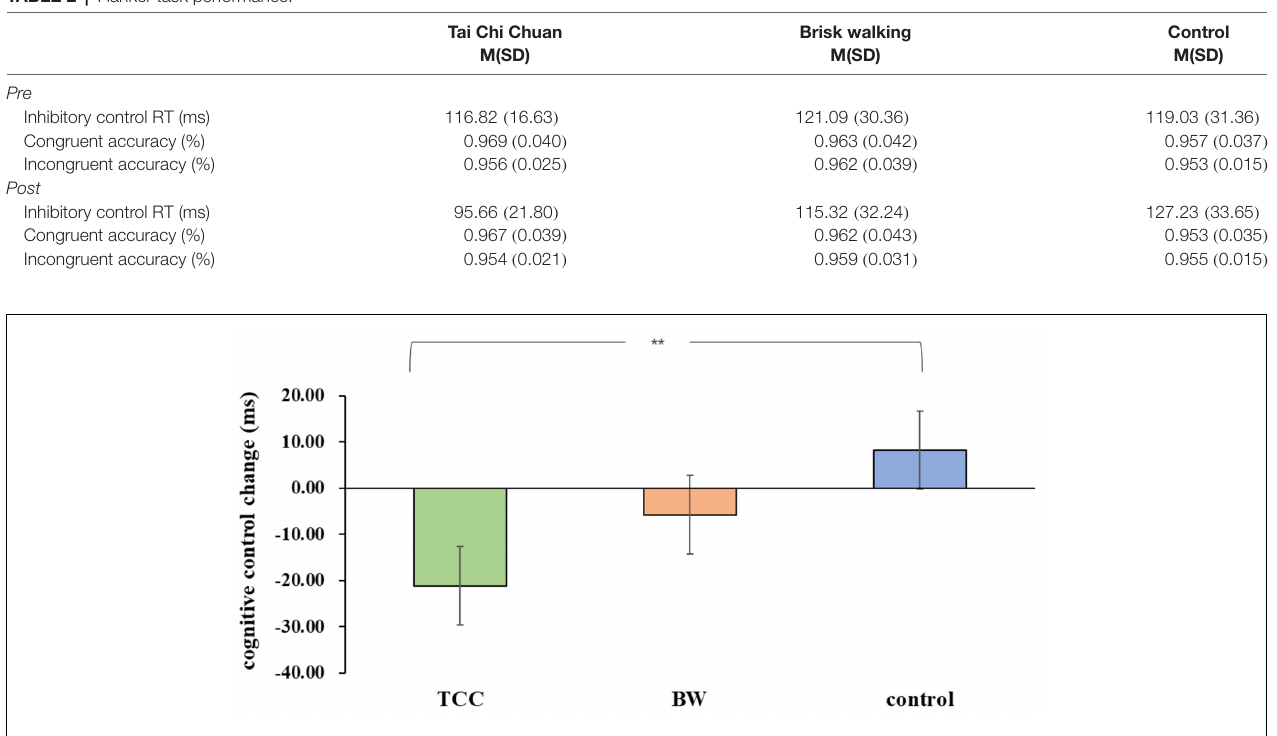
FIGURE 1 | Group differences in inhibitory control task reaction times (RT). ** p ≤ 0.01.